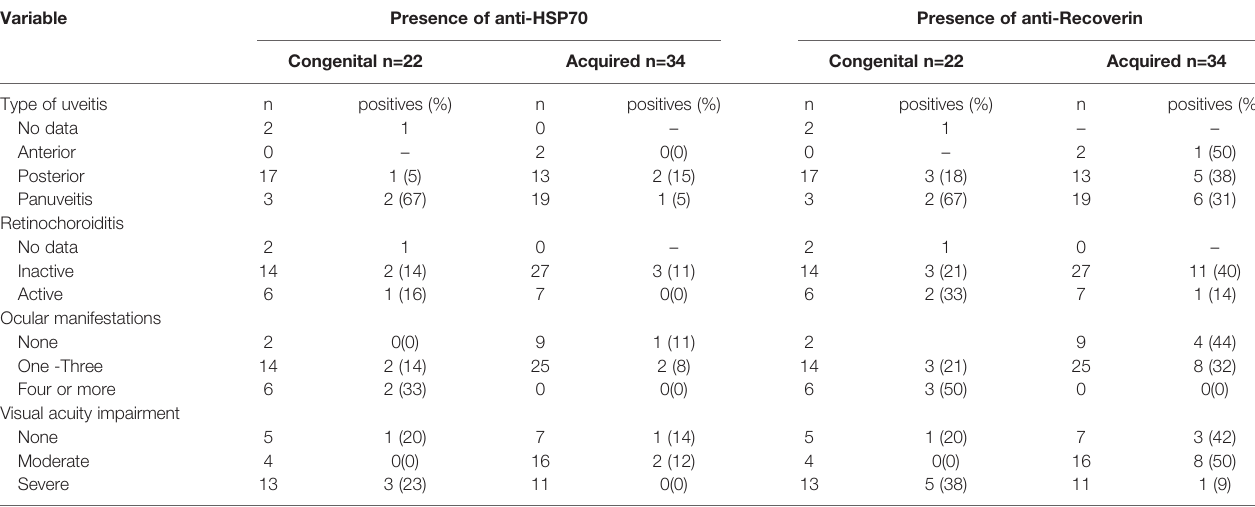
TABLE 2 | Presence of autoantibodies and clinical characteristics of patients with ocular toxoplasmosis. Variable